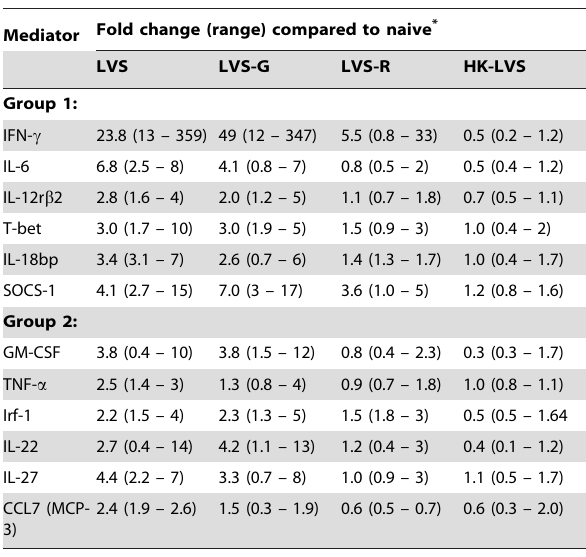
Table 1. Working panel of proposed correlates of protection for the intracellular bacterium